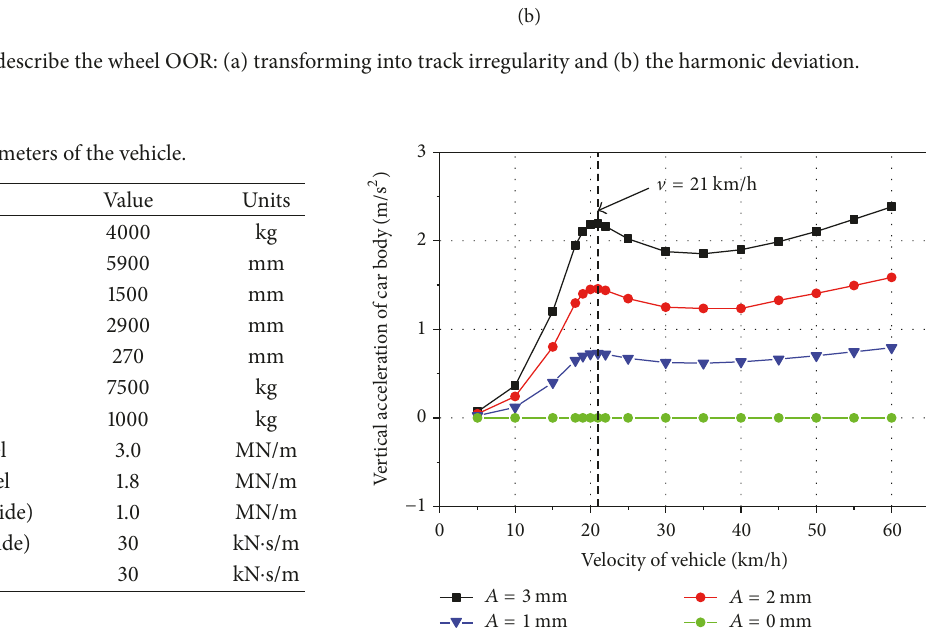
Figure 9: Vertical acceleration of car body at different speeds.